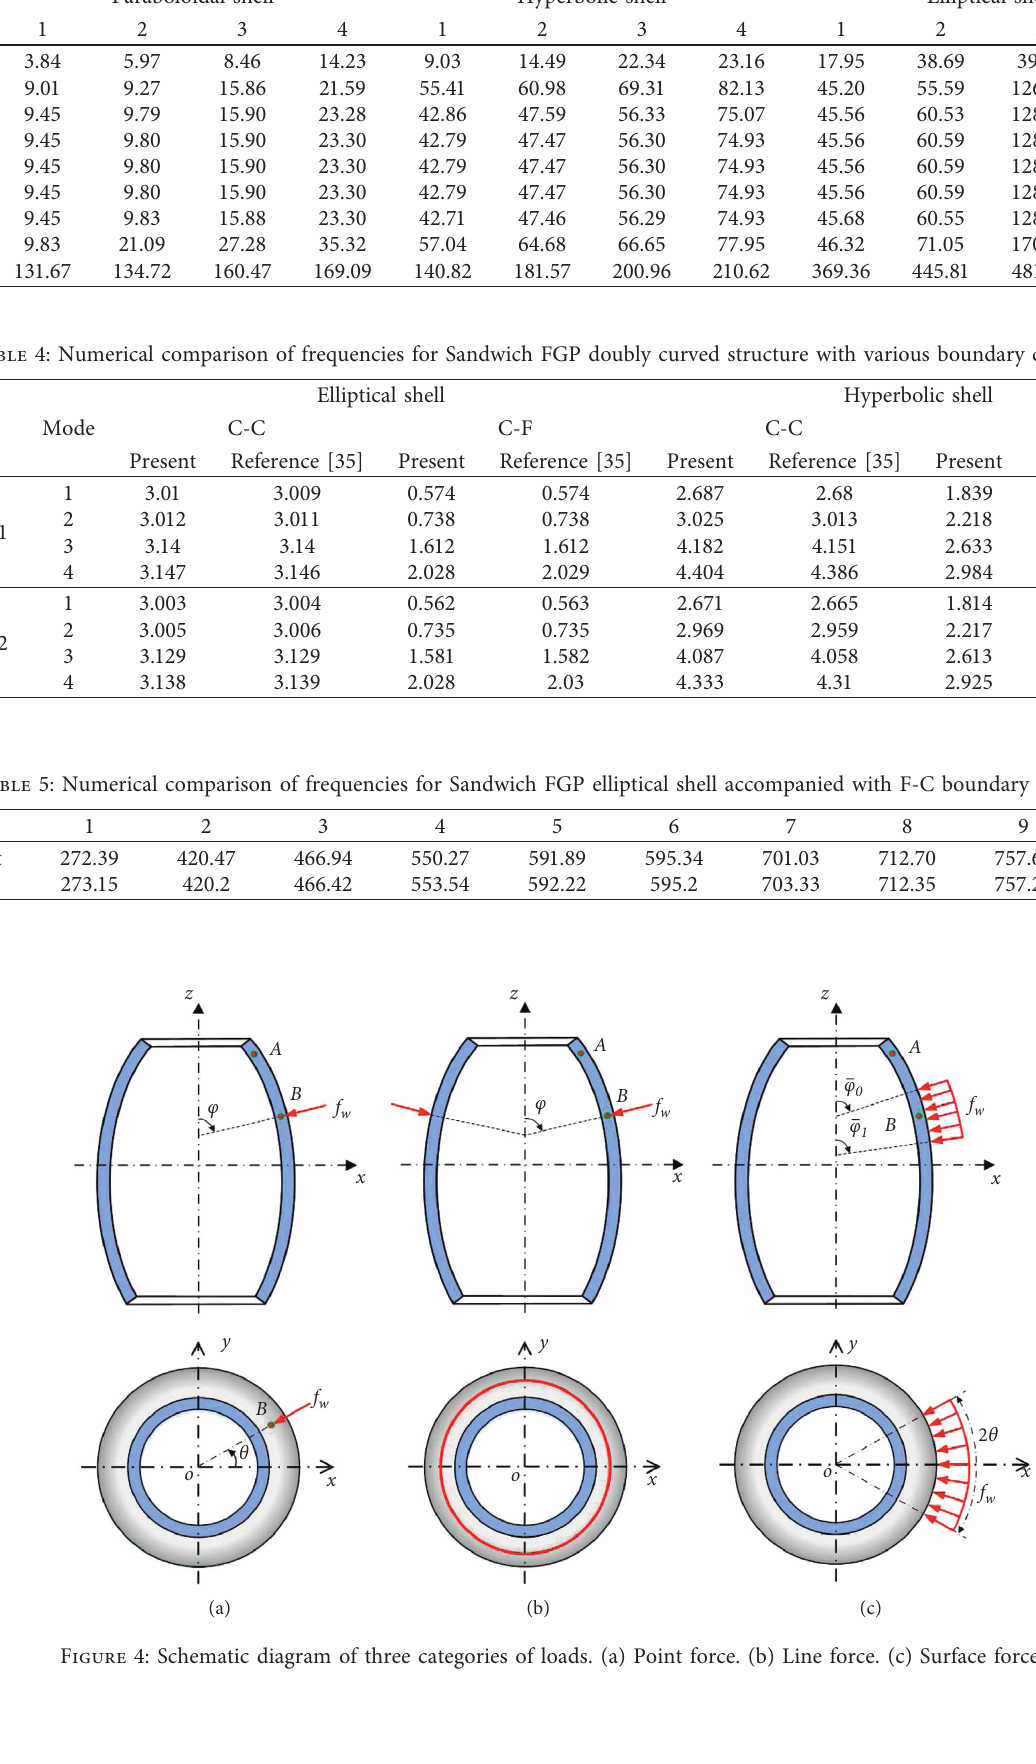
Table 3: Convergence analysis of weighted parameters for Sandwich FGP doubly curved structure. Λ